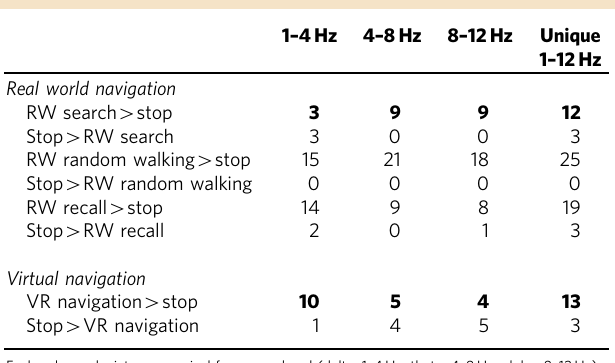
Figure 2 | Individual power spectral density plots of experimental conditions versus stop periods within their respective real-world or virtual sessions. Each plot is taken from a specific electrode contact in a patient (three patients are represented) that correspond to the raw traces in Fig. 1. Each condition’s power spectral density differs from the contrasted condition by at least P o 0.01. ( a ) Real-world search (invisible sensor task) elicits more power in high- theta than when the patient is stopped (patient #2). ( b ) Real-world search (invisible sensor task) elicits more power in low-theta from patient #4 than when the patient is stopped. ( c ) Recall of real-world spatial locations elicited greater low-frequency oscillations (2–8Hz) than the stop condition in patient #5. ( d ) Real-world random walk without cognitive demands elicits more power in high-theta than during stopping (hippocampal contact from patient #2). ( e ) In patient #5, navigation in a VR task (4-on-8 virtual maze) elicits greater low-theta oscillations than stopping in that session. ( f ) Comparisons across all experimental conditions within a single patient and electrode (patient #2). All conditions elicit low-frequency oscillations, real-world random walking eliciting the highest. Grey bar indicates a significant difference at P o 0.01. Table 2 | Electrode contacts showing significant differences between movement and stop